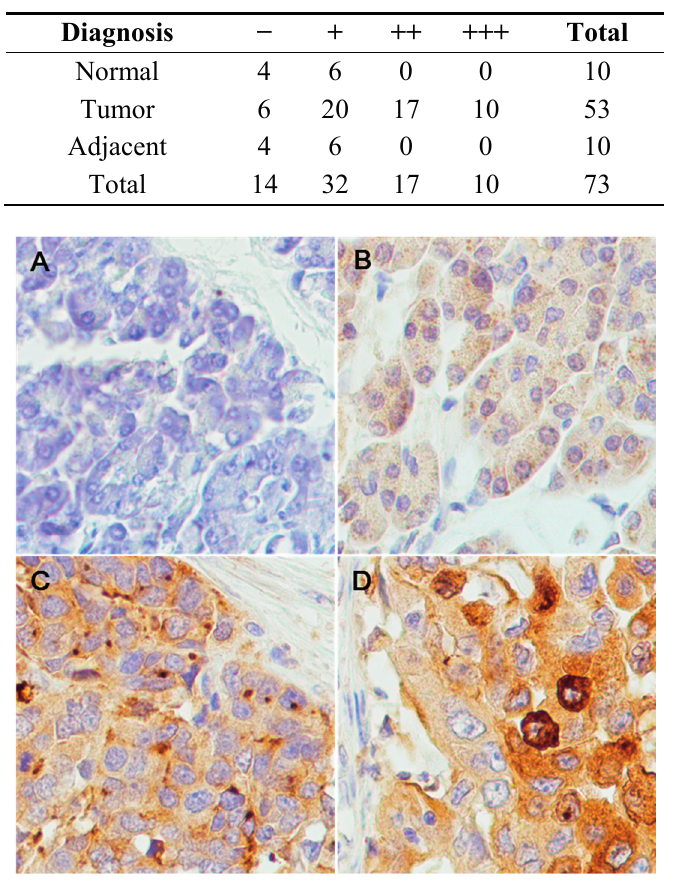
Table 1. Immunohistochemistry score in pancreatic tissue microarrays. Each tissue microarray (TMA) core of 10 normal, 53 pancreatic tumor and 10 adjacent tissues was scored as negative ( − ), weak positive (+), medium positive (++), and highly positive (+++). Analysis on the HE4 level of three groups showed a significant increase of HE4 protein levels in tumor group compared to normal and adjacent group respectively. ( p = 0.00, Kruskal–Wallis nonparametric correlations).